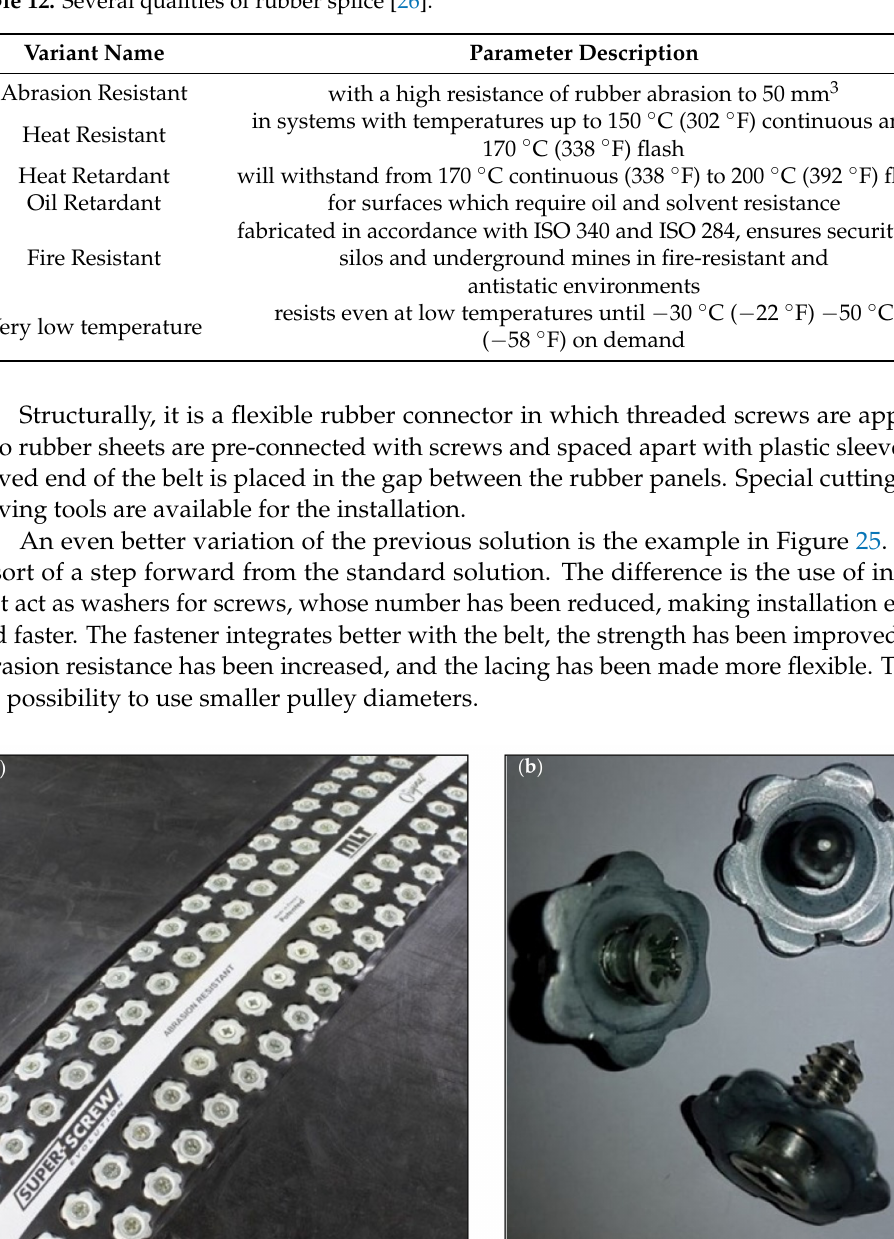
Table 12. Several qualities of rubber splice [26].